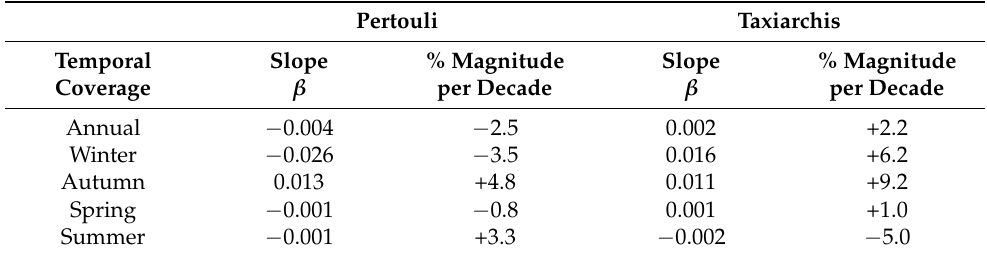
Table 2. Sen slope β values and trend magnitude (%) per decade for the P/PET ratio.